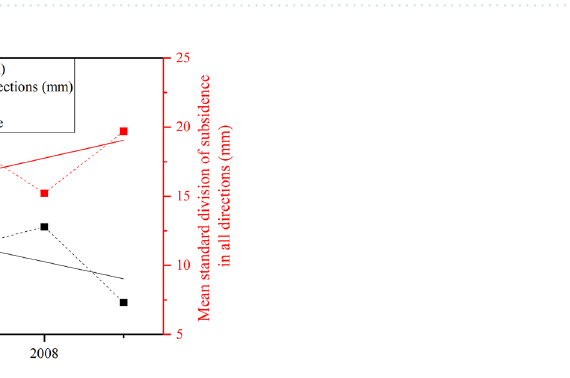
Figure 6. The detected change points result for subsidence. The red dots represent the change points of subsidence. ( a ) Change points of F1-3 at WSY station. ( b ) Change points of F2-3 at WJ station. ( c ) Change points of F3-7 at the TZ station.